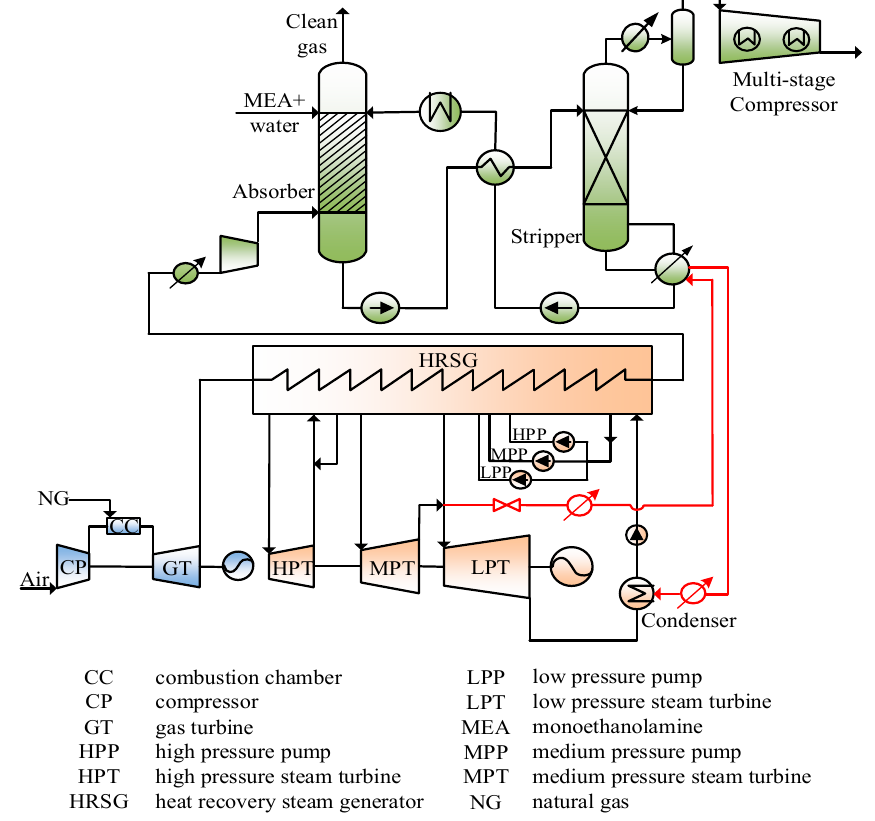
Figure 1. Schematic of a typical NGCC power plant with CO 2 capture.